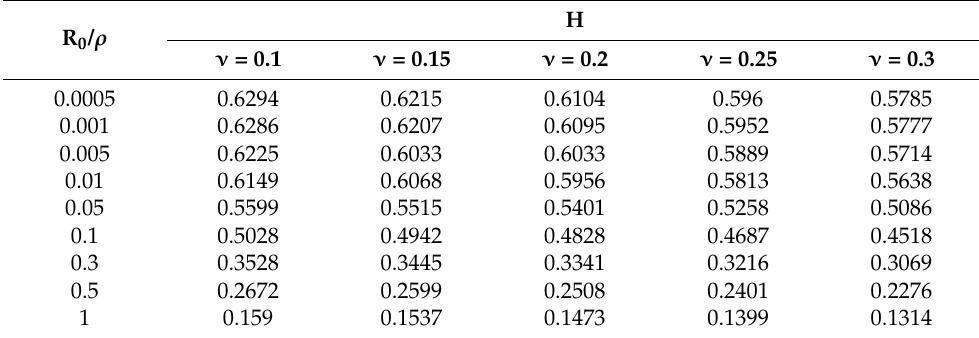
Table 1. Values of H for U-shaped notches